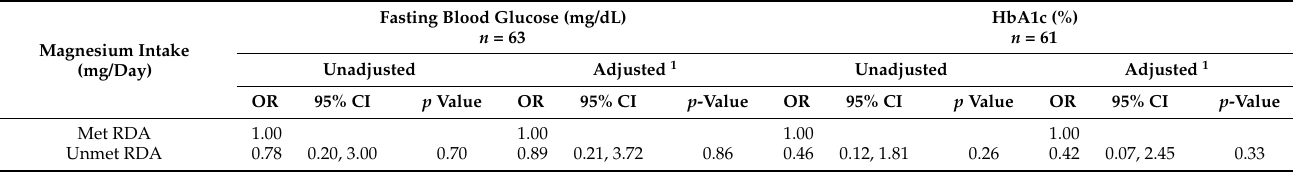
Table 3. Risk of hyperglycemia in women of reproductive age according to magnesium